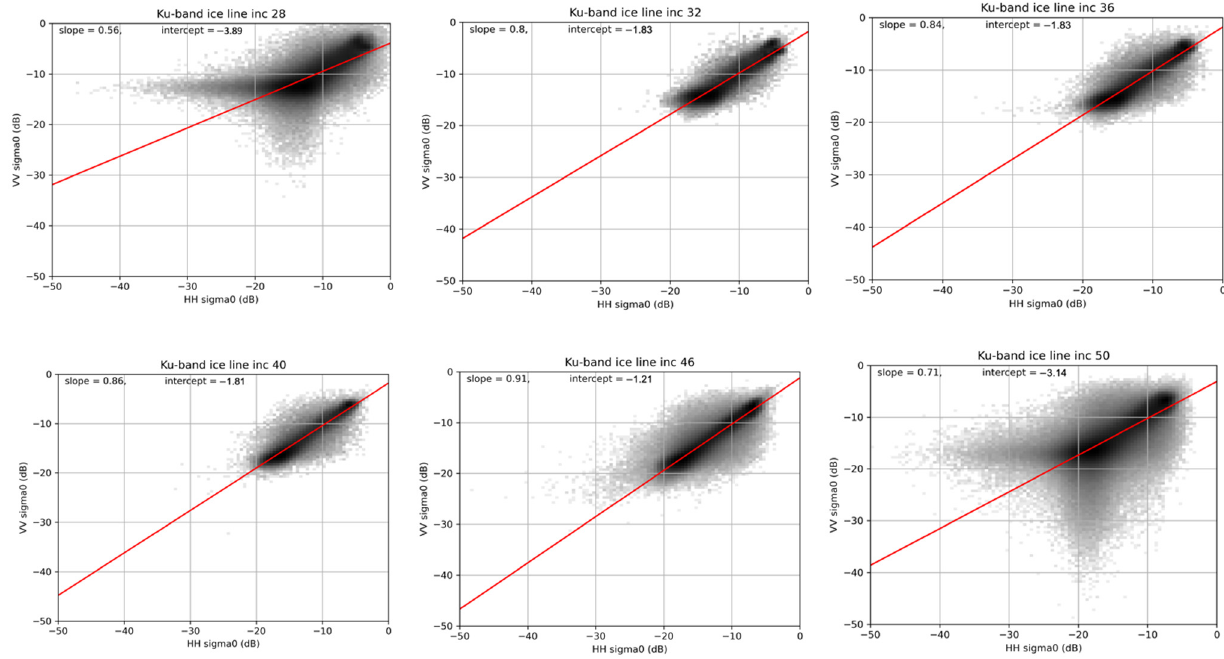
Figure 2. Daily slopes in the linear ice model in the Arctic per incidence angle in the year 2019 (a 2° incidence interval is used for a clearer look).